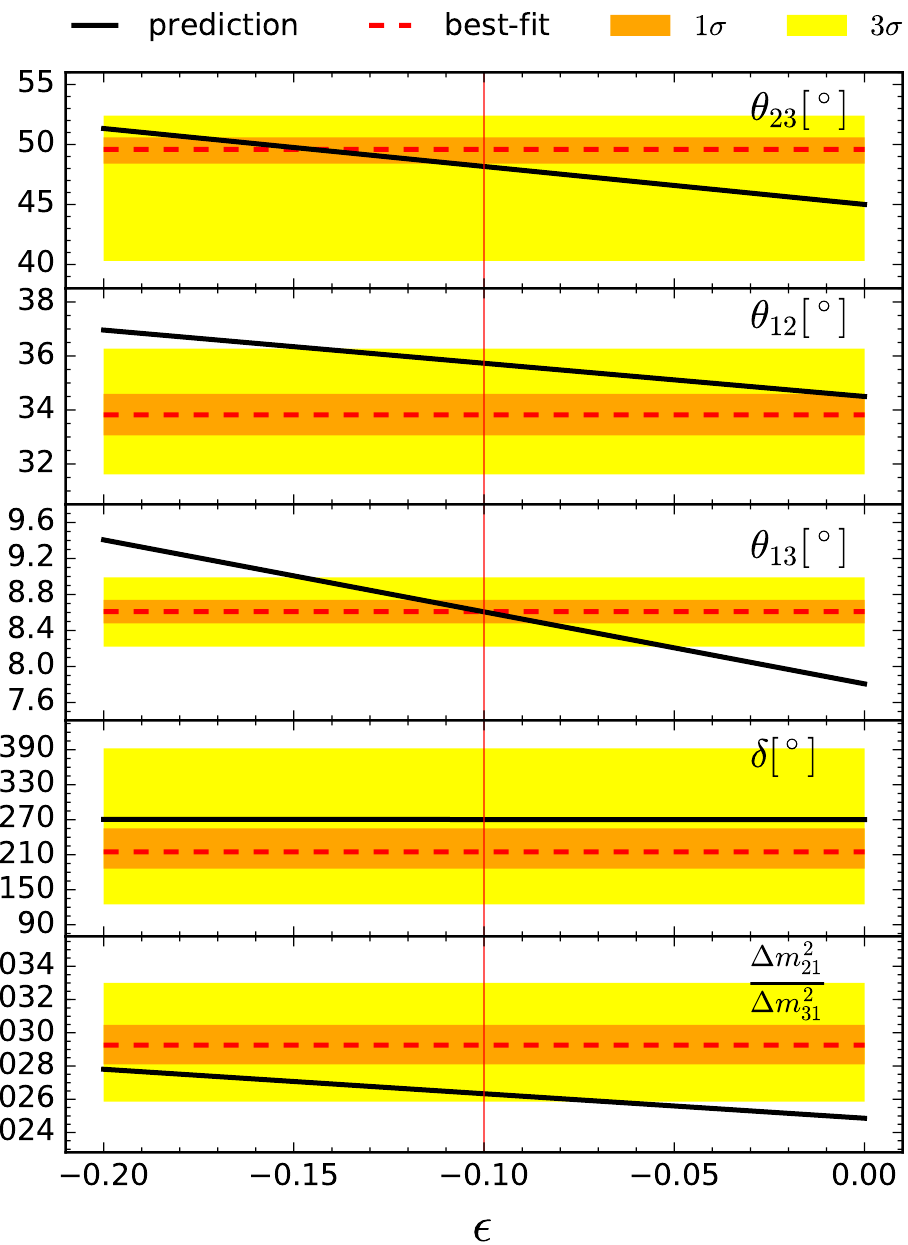
Figure 1 . Oscillation parameters modi(cid:12)ed by radiative corrections in case I of the (cid:22)(cid:28) -LSS model. Best-(cid:12)t values, 1 (cid:27) and 3 (cid:27) ranges of global (cid:12)ts data of neutrino oscillation experiments are shown as comparisons.